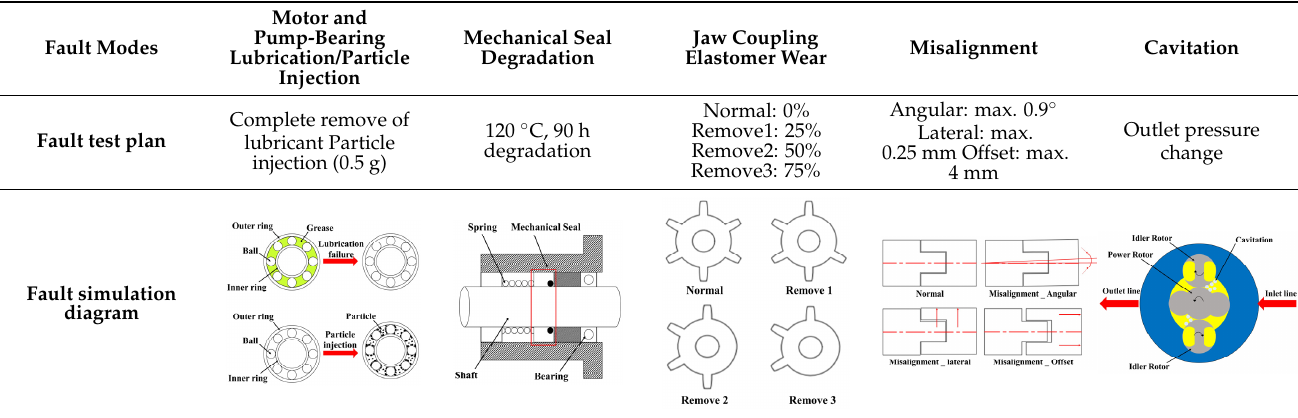
Table 2. Fault simulation scenario for 5 types of the fault modes of pump.